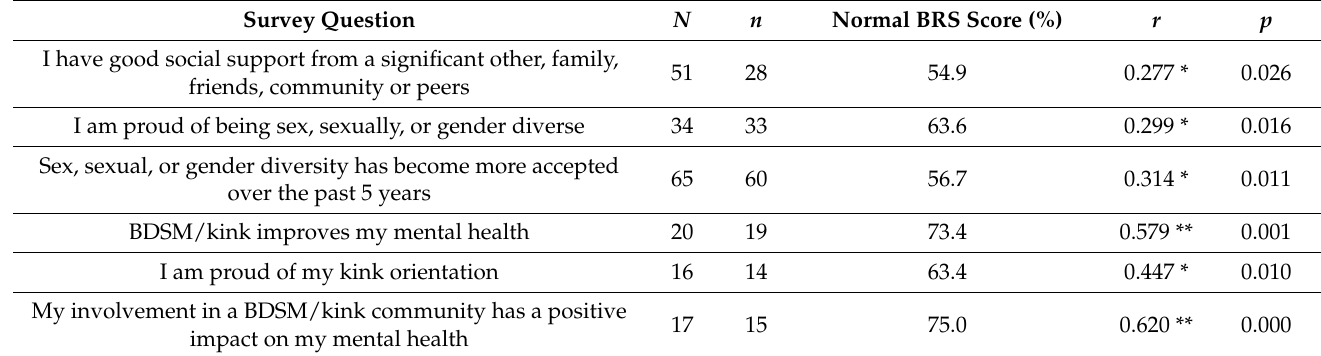
Table 2. Factors Significantly Associated with Normal Resilience Among LGBTIQA+ Survey Partici- pants in Rural Tasmania